Question: Author a descriptive caption for the visualization shown.
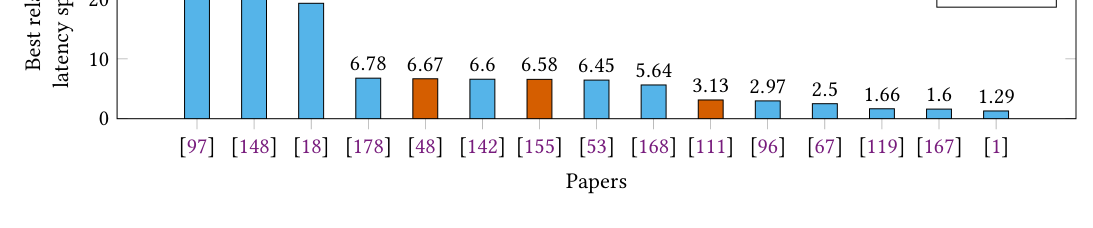
Answer: Best latency speedup (when compared against the case with only one edge device) reported for papers using horizontal partitioning